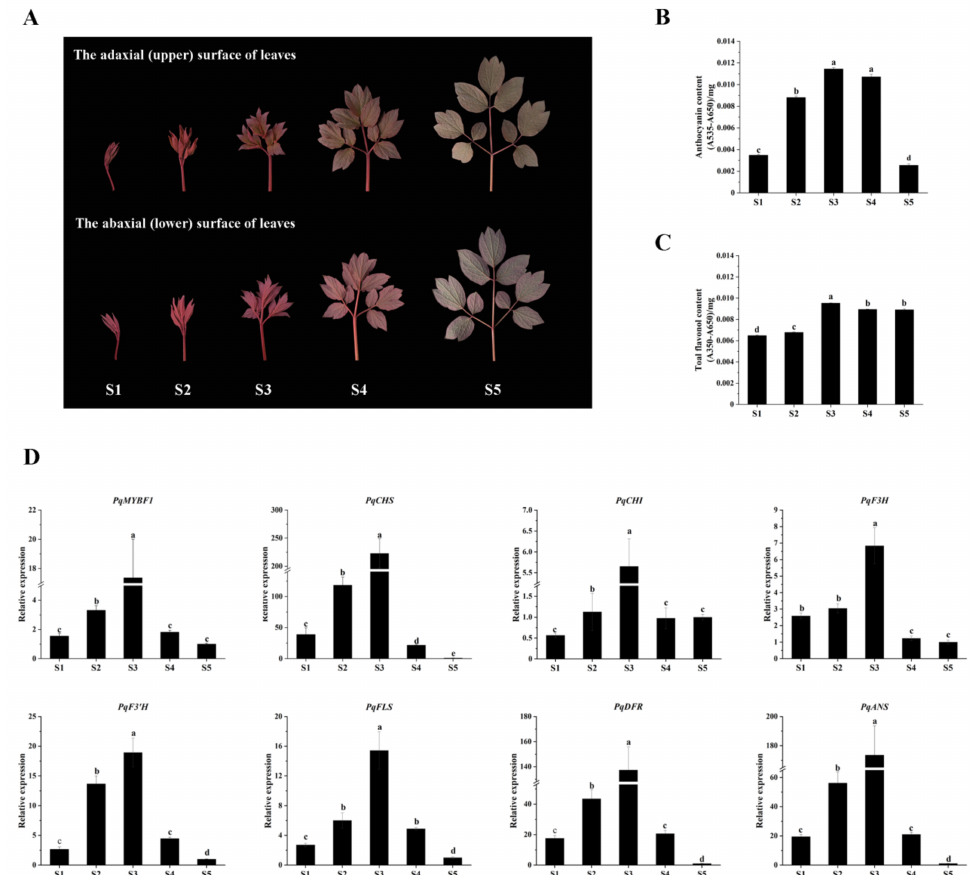
Figure 3. Leaf phenotypes in different states of Paeonia qiui and expression level of flavonoid structural genes and PqMYBF1 at different stages in P. qiui . ( A ) The adaxial (upper) and abaxial (lower) surface of P. qiui leaves at different stages. The leaf development was divided into five stages mainly based on leaf status and pigmentation: S1: the leaves curled up; S2: the leaves extended slightly; S3: the leaves basically unfolded; S4: the leaves unfolded completely; S5: the leaves turned green. ( B ) Anthocyanin content in P. qiui . ( C ) Total flavonol content in P. qiui . ( D ) The expression level of PqMYBF1 , PqCHS , PqCHI , PqF3H , PqF3 (cid:48) H , PqFLS, PqDFR, and PqANS . a, b, c, and d indicate significant differences at the p ≤ 0.05 level in the Duncan